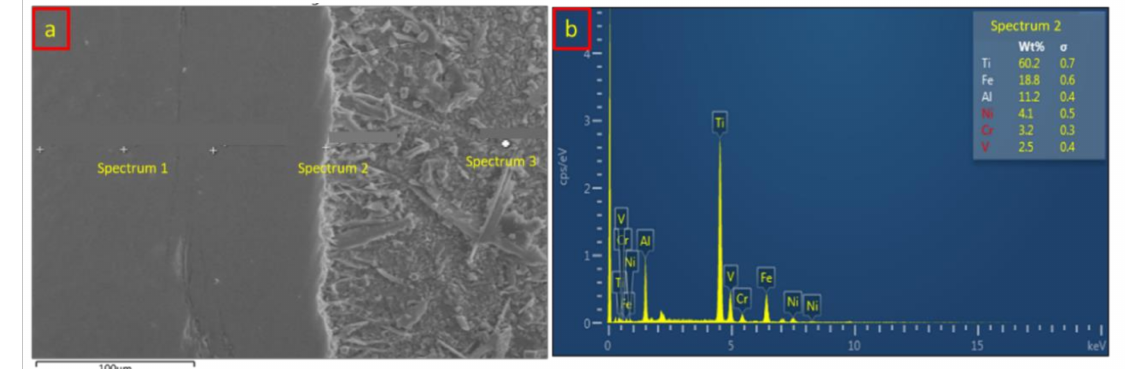
Figure 12. ( a ) SS/Al spectrum distribution of the EDX analysis from sample 3; ( b ) SS/Al EDX analysis result on the IMC layer from sample 3.